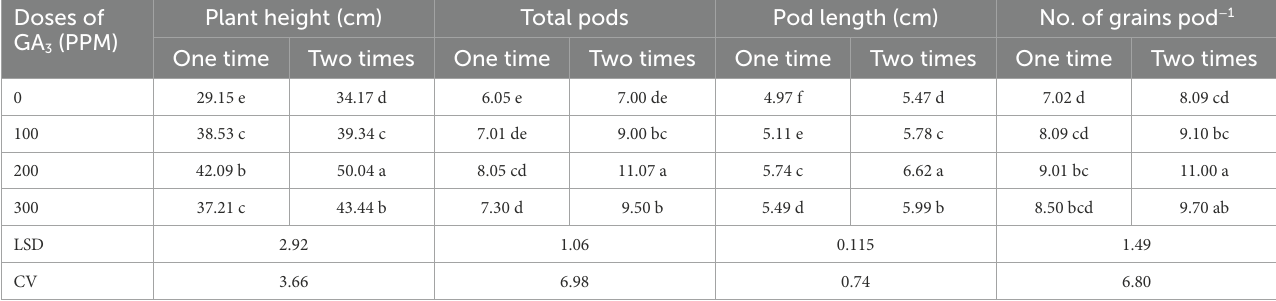
TABLE 5 Reproductive yield attributes of mungbean as influenced by exogenously applied GA 3 in different concentrations and frequencies. Doses of Plant height GA (PPM) 3